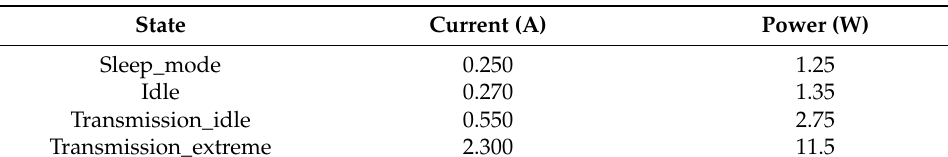
Table 3. SCU power ratings.